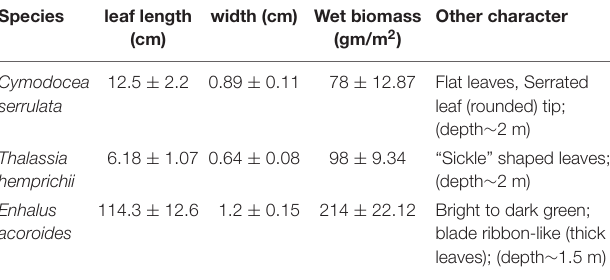
TABLE 1 | Morphological features and other important character of the studied seagrass